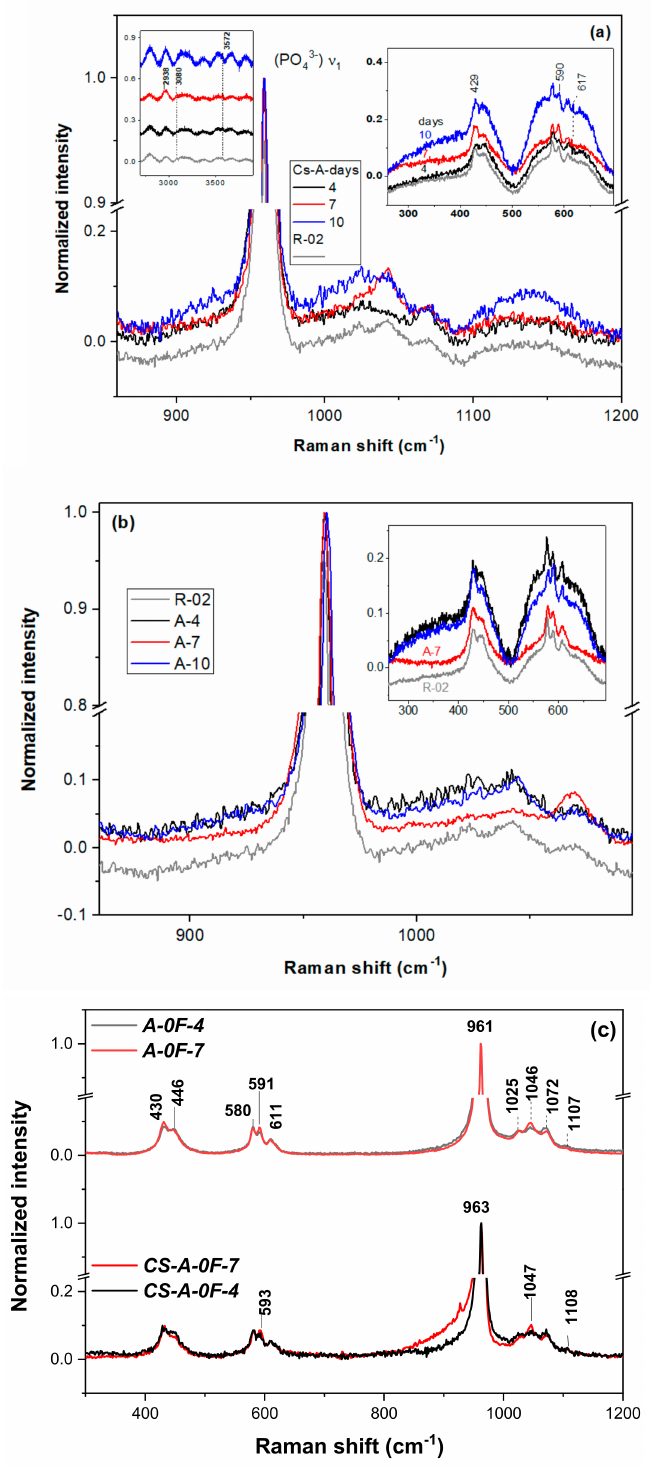
Figure 10. Raman spectra of etched R-02 and CS-A-(4/7/10) samples ( a ); A-(4/7/10) samples (514 nm laser); ( b ) (A/CS-A)-0F-(4/7) samples (325 nm excitation); ( c ) CS-4-A and R-02 spectra were down-shifted for